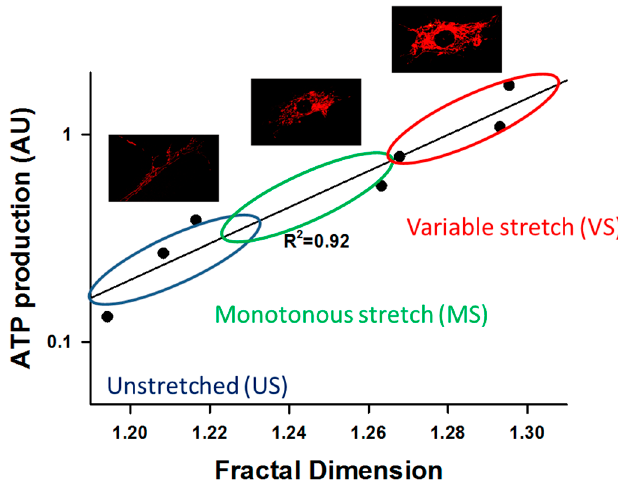
Figure 4. Relationship between complexity, measured by the fractal dimension D f , and function, assessed by a fluorescent dye (TMRM, see text) intensity that is related to ATP production rate in VSMCs. There is a linear relation between the log of ATP production and D f . The dots represent binned data from about 2000 cells showing unstretched control cells (US), 4 h of monotonously stretched (MS) cells (10% area strain at 1 Hz), and 4 h of stretching cells with a variable stretch (VS) pattern in which every cycle is different with the amplitudes uniformly distributed between 7.5% and 12.5% area strain. The US cells are in the lower left corner. These cells produce little energy and their mitochondrial fractal organization is the least complex. MS cells produce somewhat more energy and their D f is also higher, whereas VS cells produce the most ATP and have the highest complexity in terms of their fractal organization. The images show mitochondrial networks corresponding to US, MS, and VS cells. ATP production rate is related to the intensity of red color. The results were obtained by reanalyzing the data from [14].